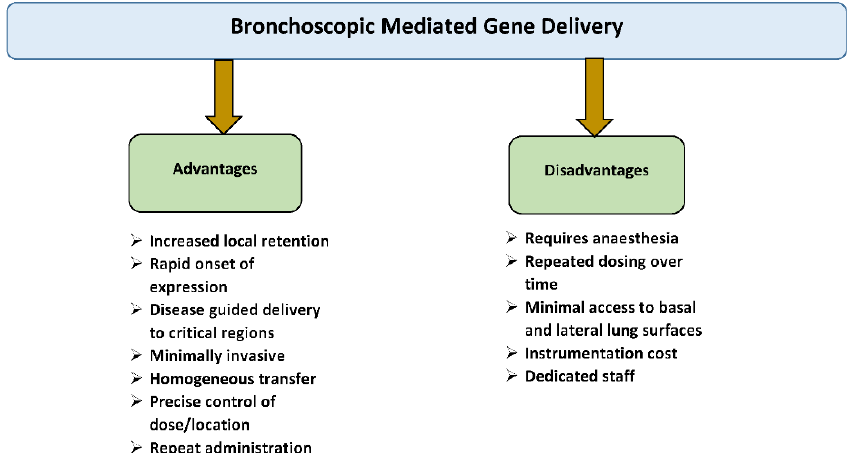
Figure 4. The advantages and disadvantages of bronchoscopic (intratracheal)-mediated gene